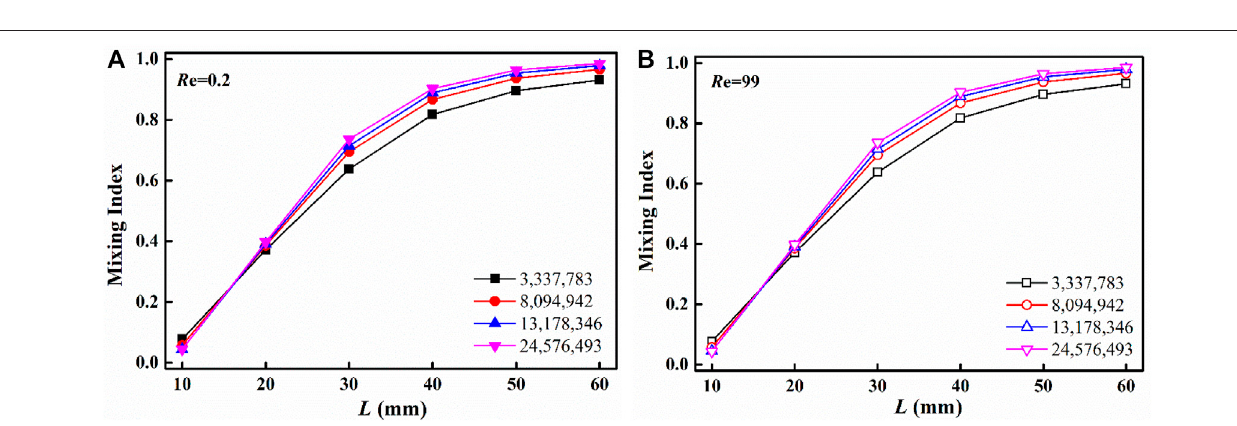
Frontiers in Chemical Engineering |